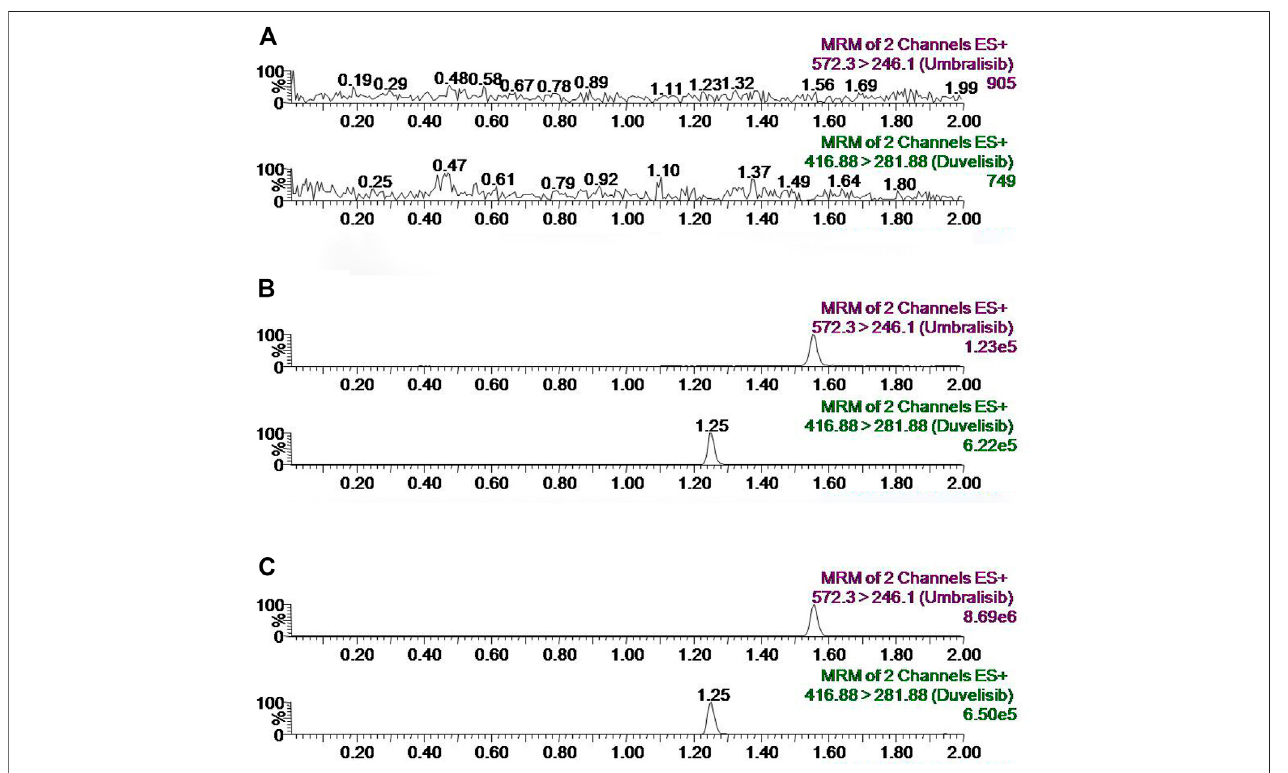
FIGURE 2 | Representative chromatograms of umbralisib and IS in rat plasma: (A) blank plasma; (B) blank plasma spiked with LLOQ concentration of standard solutions; (C) sample obtained from a rat at 0.333 h after oral administration of 80 mg/kg umbralisib and dealed with preparation with IS.